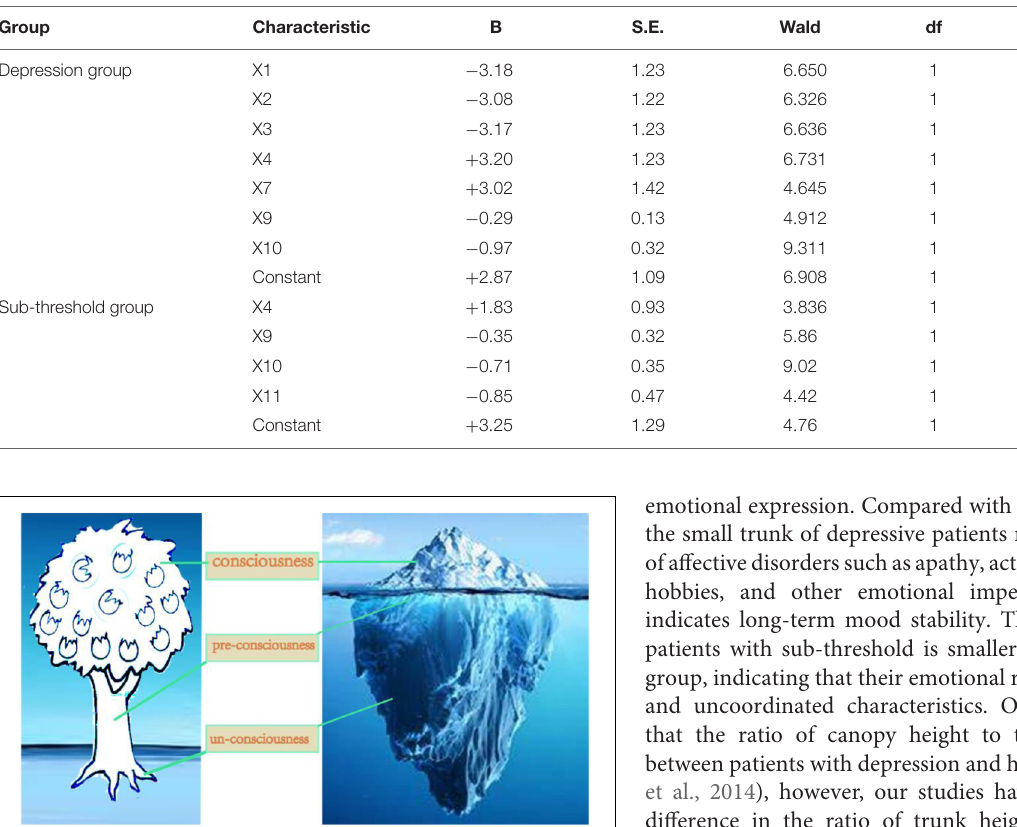
depth, while the length represents the degree of domination of emotional mood (Ji, 2011). The core symptoms of depression patients include moodiness or depression, lack of interest, and loss of interest (Xie and Ye, 1994). The small trunk area of patients with depression reflects their negative mood and pessimism; the short trunk reflects their poor emotional control; the narrow width reflects their emotional vulnerability (Matt, 2015). An appropriate trunk area, height, and width might indicate a stable